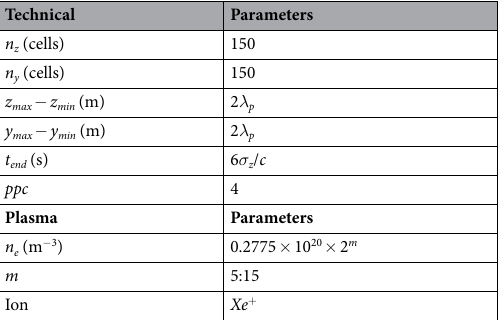
Table 2. Technical and plasma parameters. n z is the grid cell length, n y is the grid cell width, z max − z min is the grid length, y max − y min is the grid width, t end is the run time, ppc is the particles per cell, n e is the electron number density, m is the variable scanned over and Ion is the plasma ion species.